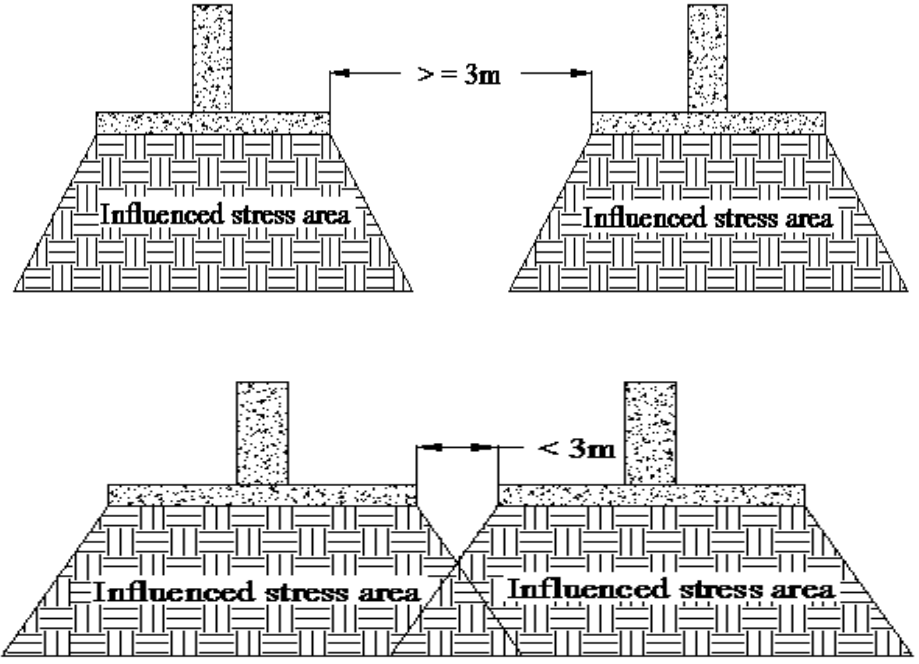
Fig. 16. Influenced stress area on sandy soil after application of load on